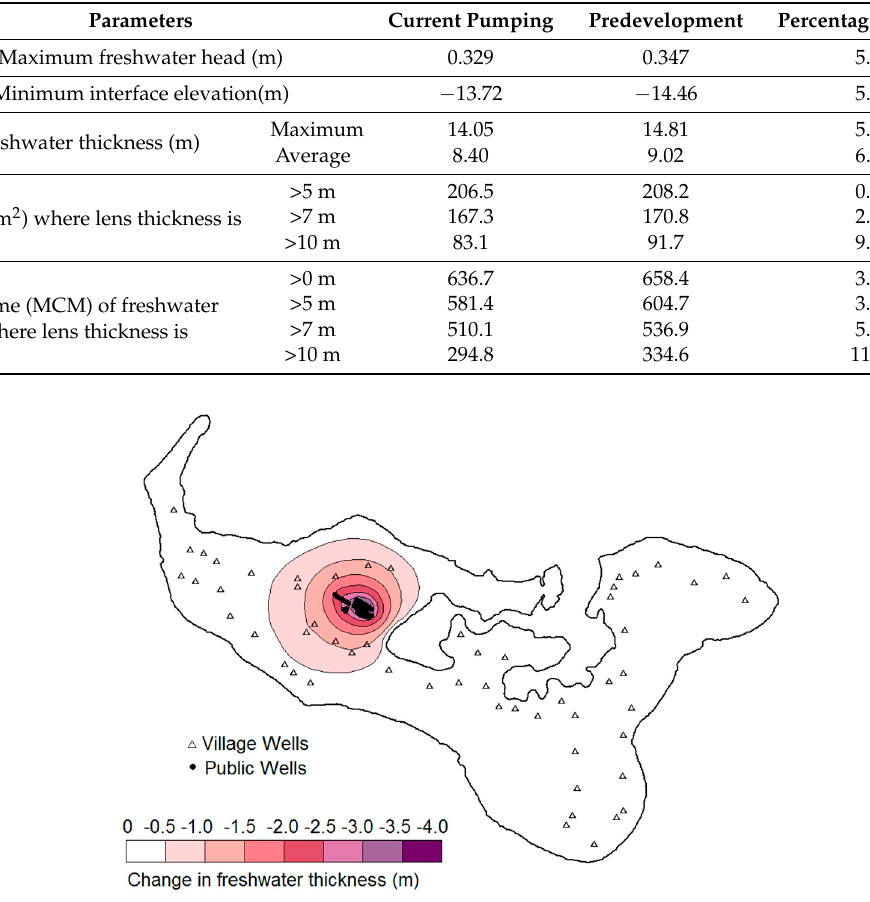
Figure 4. Impact of current groundwater development on the predevelopment freshwater lens. Contours indicate the difference between post development and predevelopment freshwater thickness.